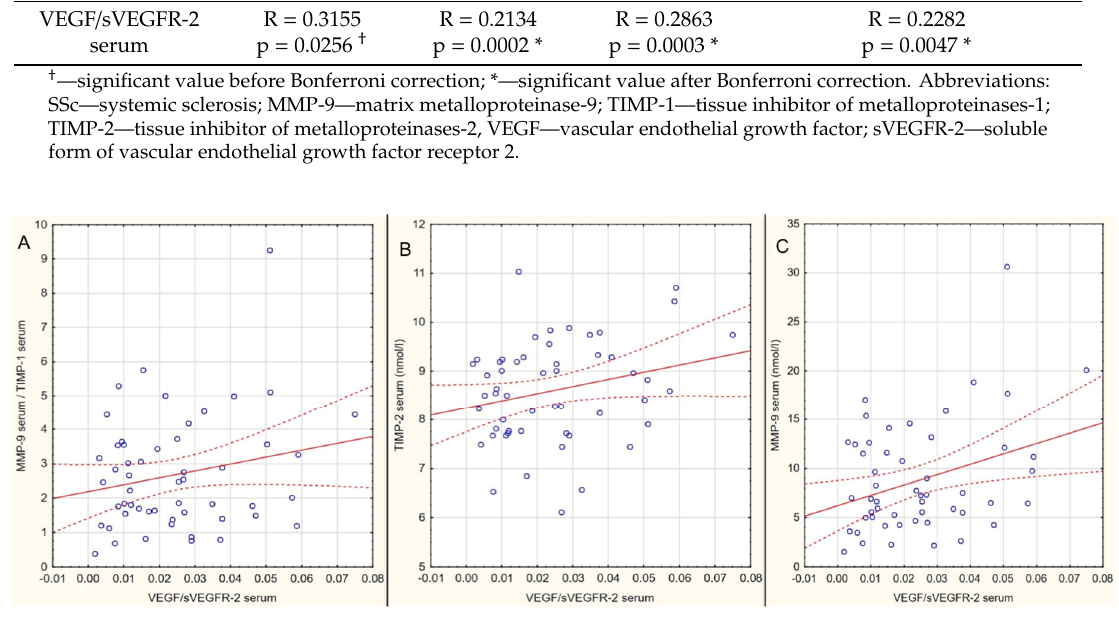
Figure 3. Analysis of all MMPs, TIMPs, VEGF, and sVEGFR-2 tears and blood serum samples from SSc patients and controls. Significant positive correlations were detected between levels of MMP-9/TIMP-1 and VEGF/sVEGFR-2 serum ( A ), TIMP-2 and VEGF/sVEGFR-2 serum ( B ), and MMP-9 and VEGF/sVEGFR-2 serum ( C ).